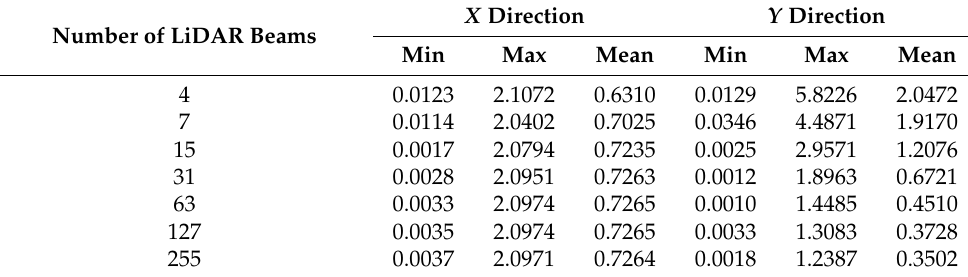
Table 3. Number of LiDAR beams and calibration